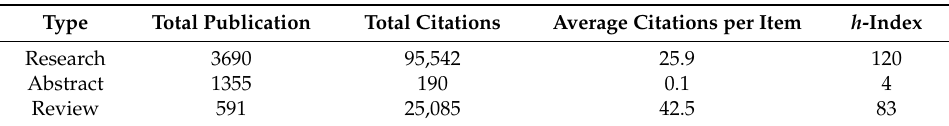
Table 4. The publication and citation impacts of original research papers, abstract, and review papers in H 2 SBM research.